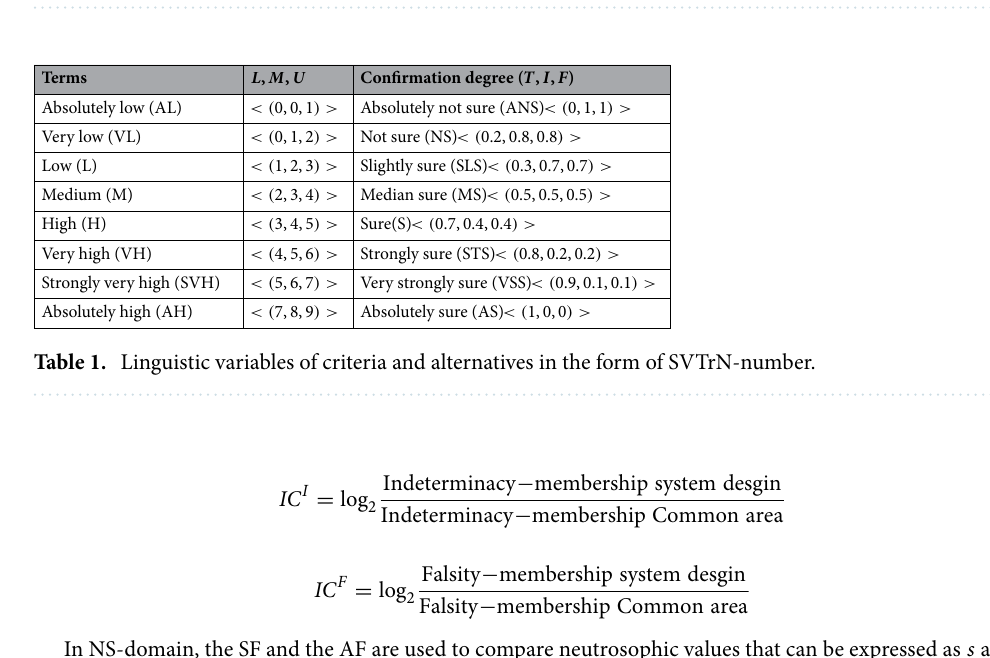
Figure 3. The intersection region between SR and DR of neutrosophic numbers.